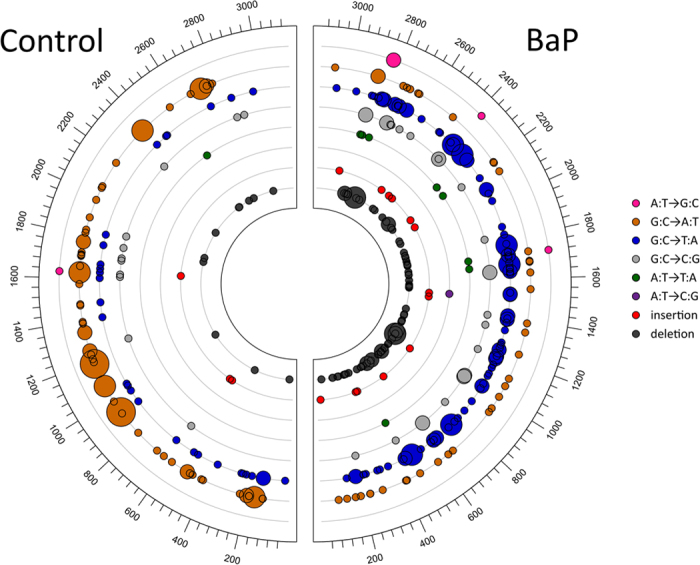
The type and position of all independent spontaneous (control) and benzo[a]pyrene(BaP)-induced lacZ mutations detected in sperm collected 42 days after the treatment period.Circle size is proportional to the number of times a mutation was detected in different animals.